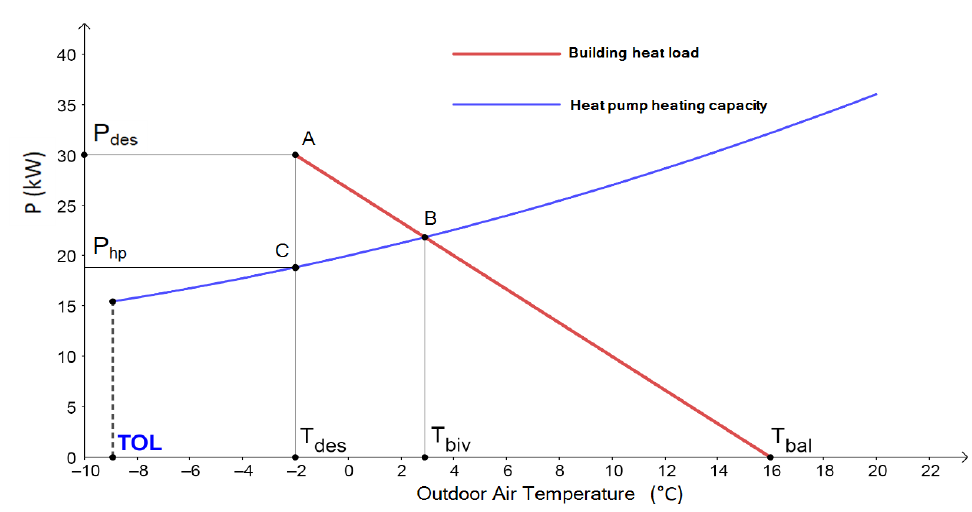
Figure 2. Building heat load line and HP’s heating capacity curve.